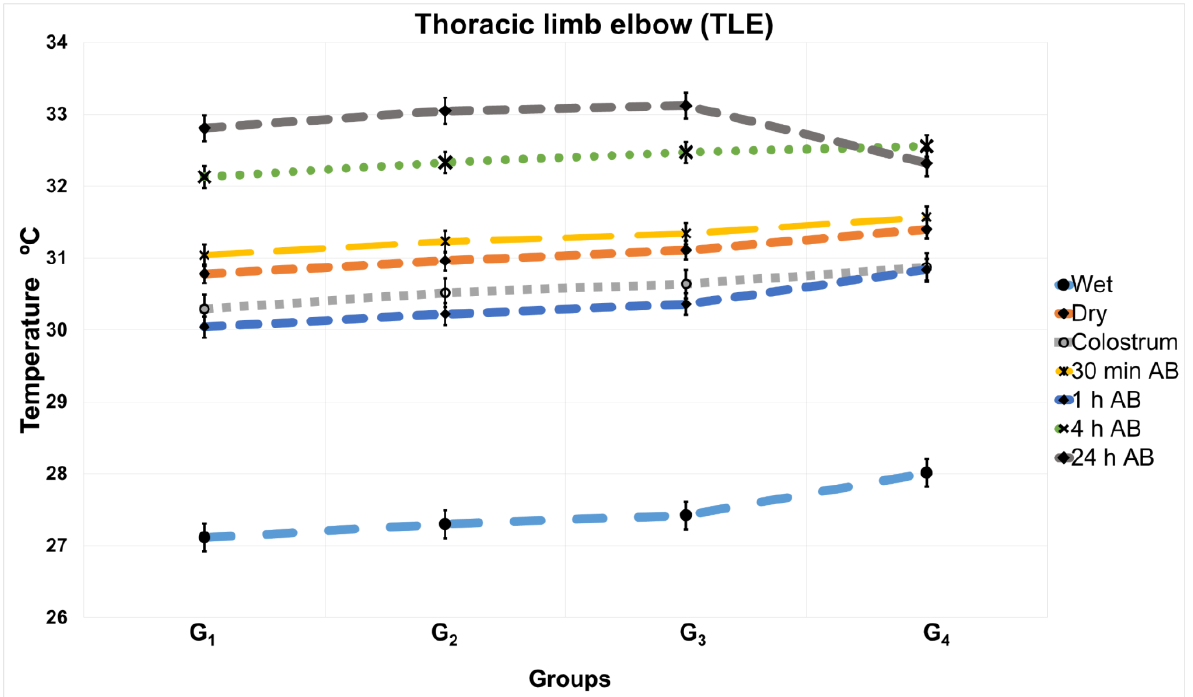
Figure 4. Interaction between group and time in thoracic limb elbow (TLE) thermal window at different times in newborn puppies from bitches classified into 4 groups according to their weight. G 1 , dams between 4 and 8 Kg; G 2 , dams between 8.1 and 16 Kg; G 3 , dams between 16.1 and 32 Kg; G 4 , dams between 32.1 and 39.6 Kg, AB: after birth.